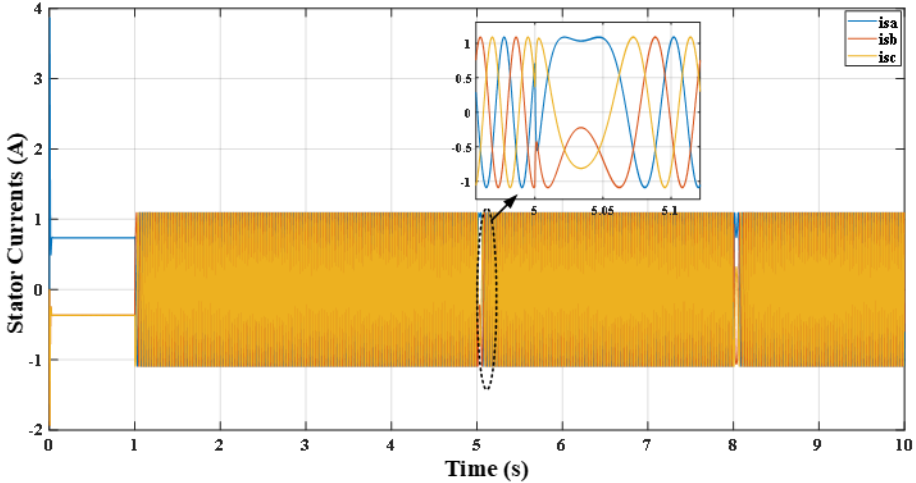
Figure 18. The testbed behaviour of the FOC algorithm three-phase current response.